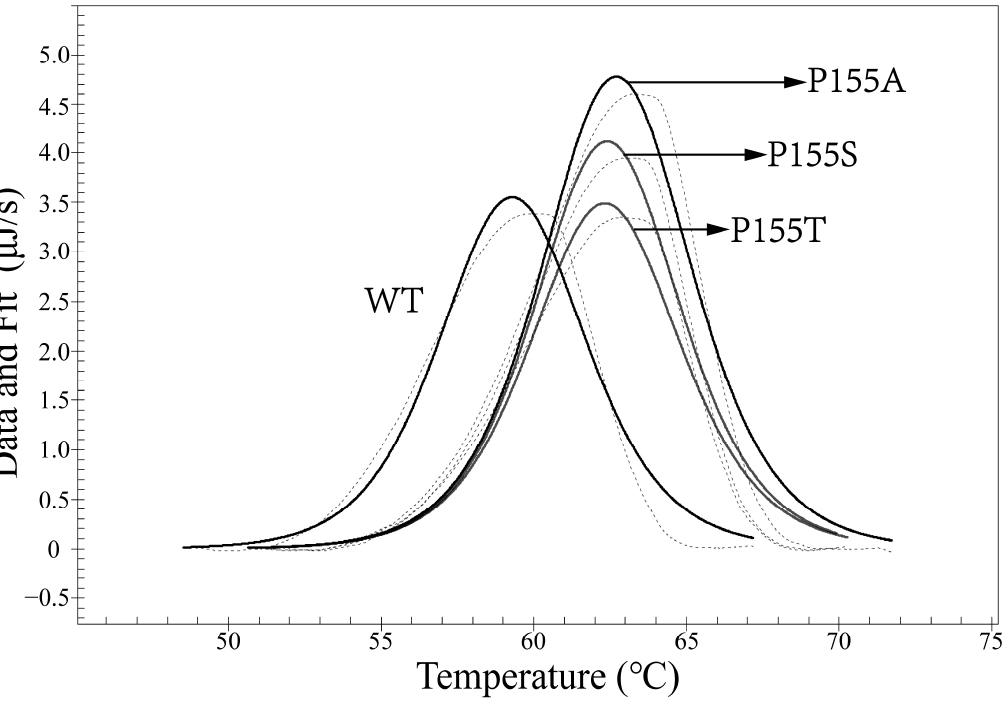
Figure 11. Differential scanning calorimetry (DSC) analysis on antibody stability. The dissolution temperature (Tm) of the WT, P155S, P155A, P155T were 59.32 °C, 62.43 °C, 62.73 °C and 62.36 °C, respectively. The dashed line shows the raw data, and the solid line shows the fitting curve.